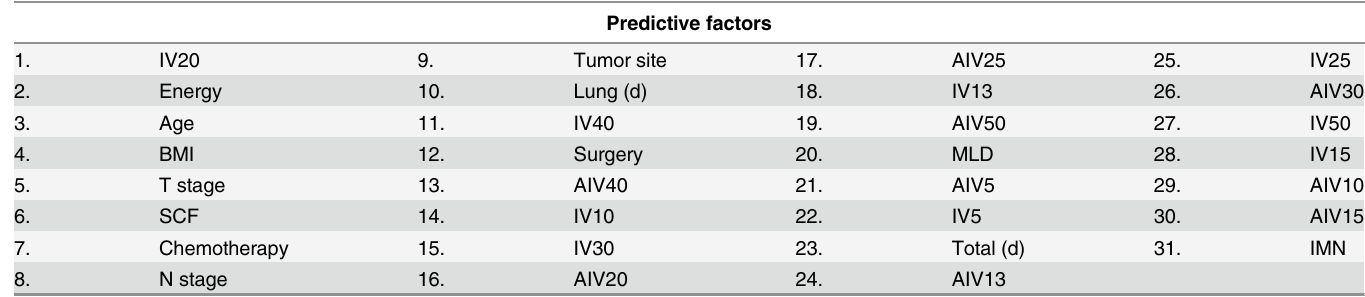
Table 3. Predictive factors correlation ranked by LASSO.